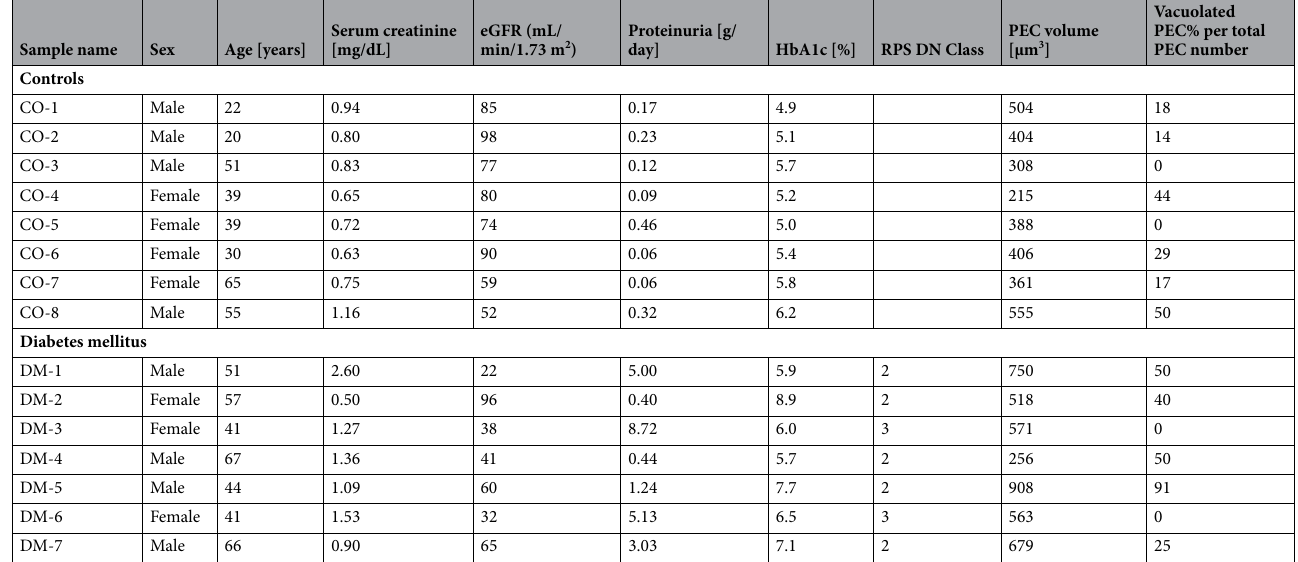
Table 1. Clinical and pathological data of controls and patients with diabetes mellitus. CO control, DM diabetes mellitus, RPS DN class scores as defined by the Renal Pathology Society Diabetic Nephropathy Classification.